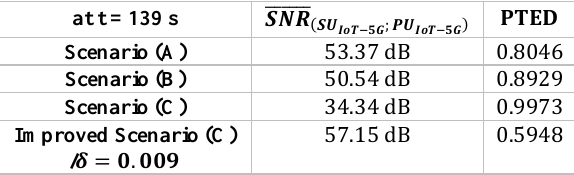
Table 5 . Sensing performances of a PS5G at 60 GHz frequency in different